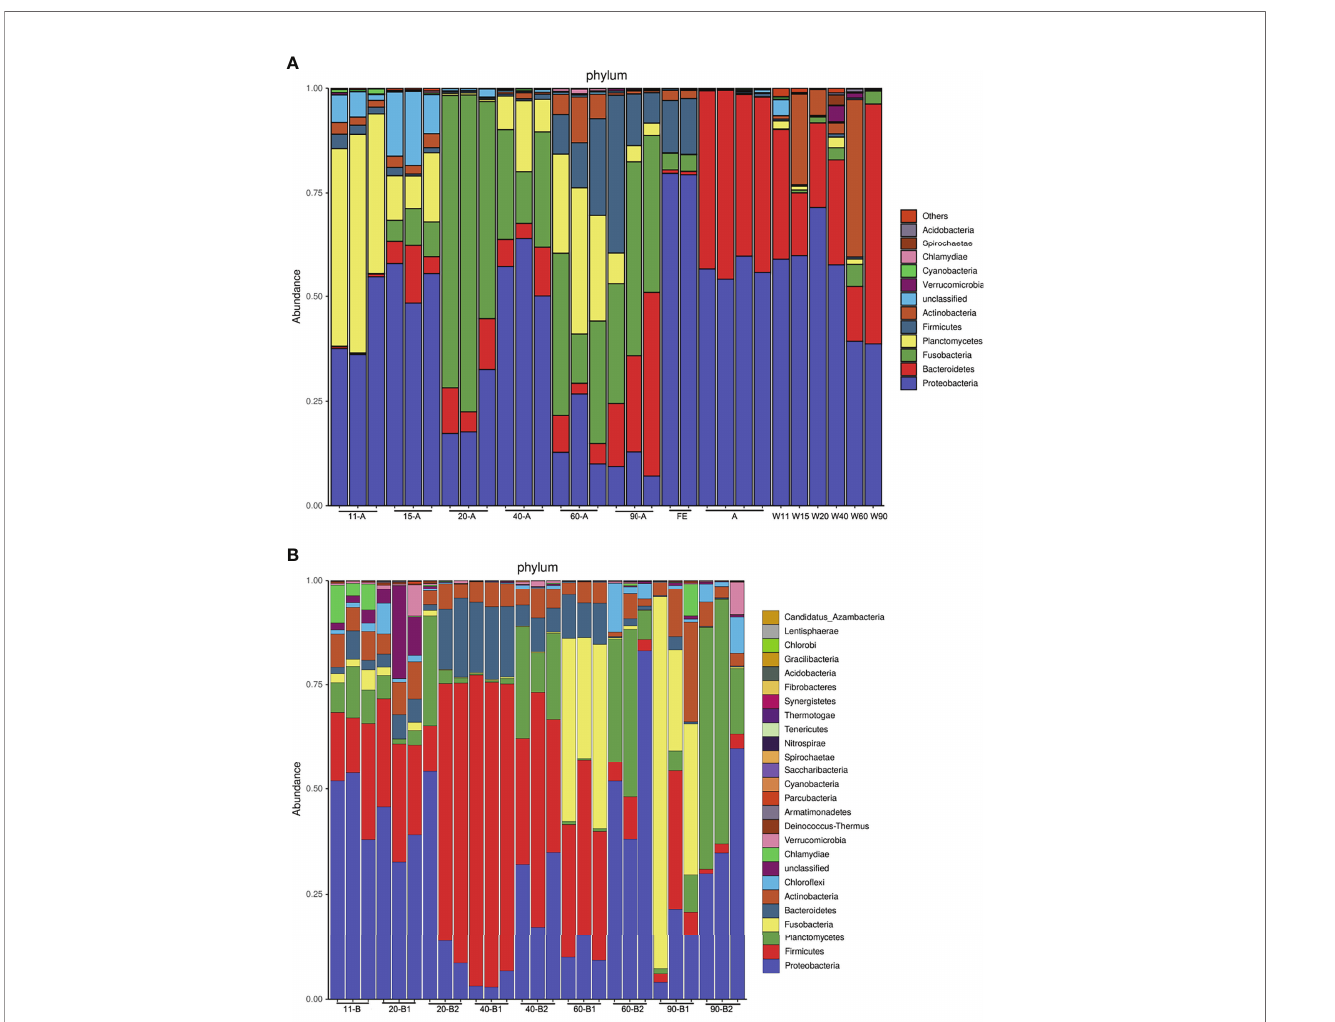
FIGURE 3 | Taxonomic composition of the microbiota community at the phylum level. (A) Experiment I and (B) Experiment II. (A) : 11-A, 15-A, 20-A, 40-A, 60-A and 90-A represent tilapia at 11, 15, 20, 40, 60 and 90 dpf with three duplicates; FE represents dry feed sampled when tilapia at 40 and 60 dpf; A represents Artemia sampled when tilapia at 15 and 20 dpf with two duplicates; W11, W15, W20, W40, W60 and W90 represent water sampled when tilapia at 11, 15, 20, 40, 60 and 90 dpf. (B) : 11-B represents tilapia at 11 dpf; 20-B1, 40-B1, 60-B1, and 90-B1 repesent tilapia at 20, 40, 60 and 90 dpf fed Artemia; 20-B2, 40-B2, 60-B2, and 90- B2 represent tilapia at 20, 40, 60 and 90 dpf fed PBD food, all with three